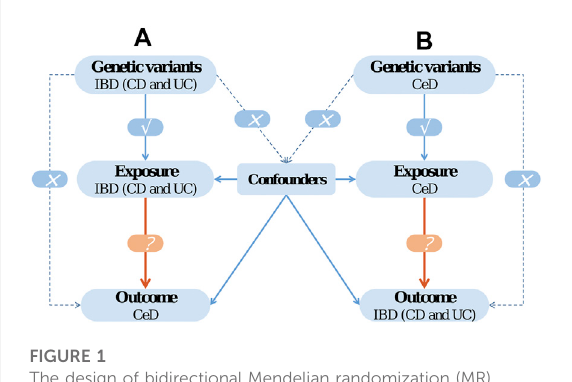
The design of bidirectional Mendelian randomization (MR) study. The ’ × ’ means that genetic variants are not associated with confounders or cannot be directly involved in outcome but via the exposure pathway. The ’ √ ’ means that genetic variants are highly correlated with